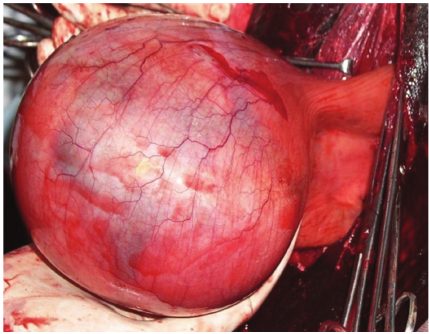
Figure 2: Uterine mass exteriorized after performing the right flank exploratory laparotomy.